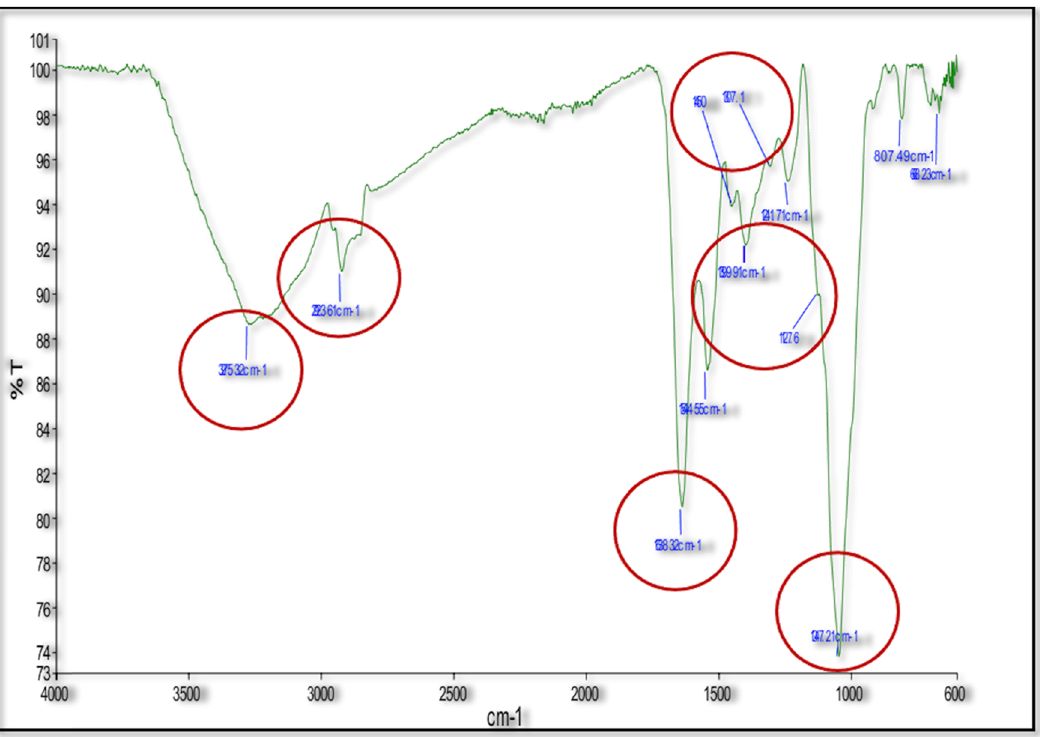
Figure 10: FTIR spectrum of extracted BNC. The highlighted peaks are the main functional groups found in the cellulose structure produced by P. kudriavzevii USM - YBP2.